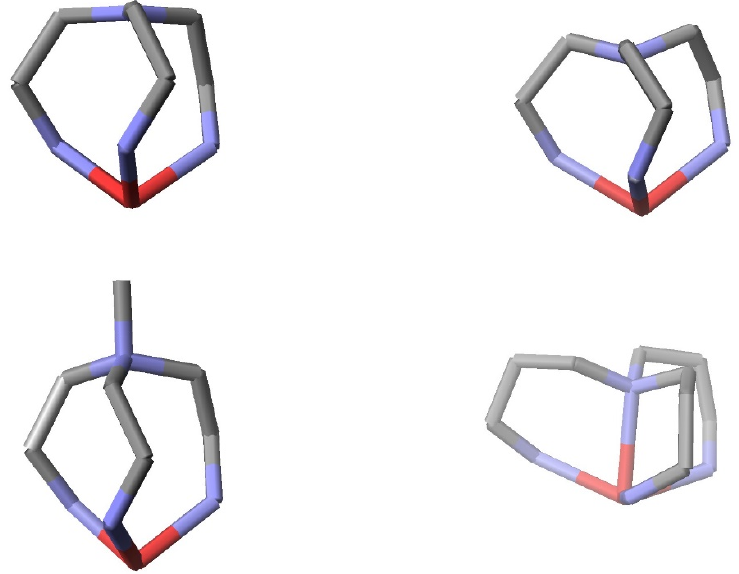
[FeNMetren(5Me-4ImH) 3 ] 3+ is an iron(II) complex even though its charge is 3+, which is due to the quaternized N ap .